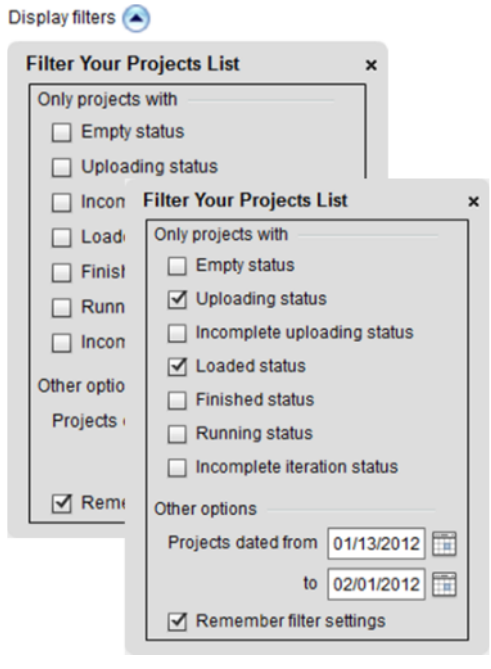
Fig. 7. Filter settings for user projects